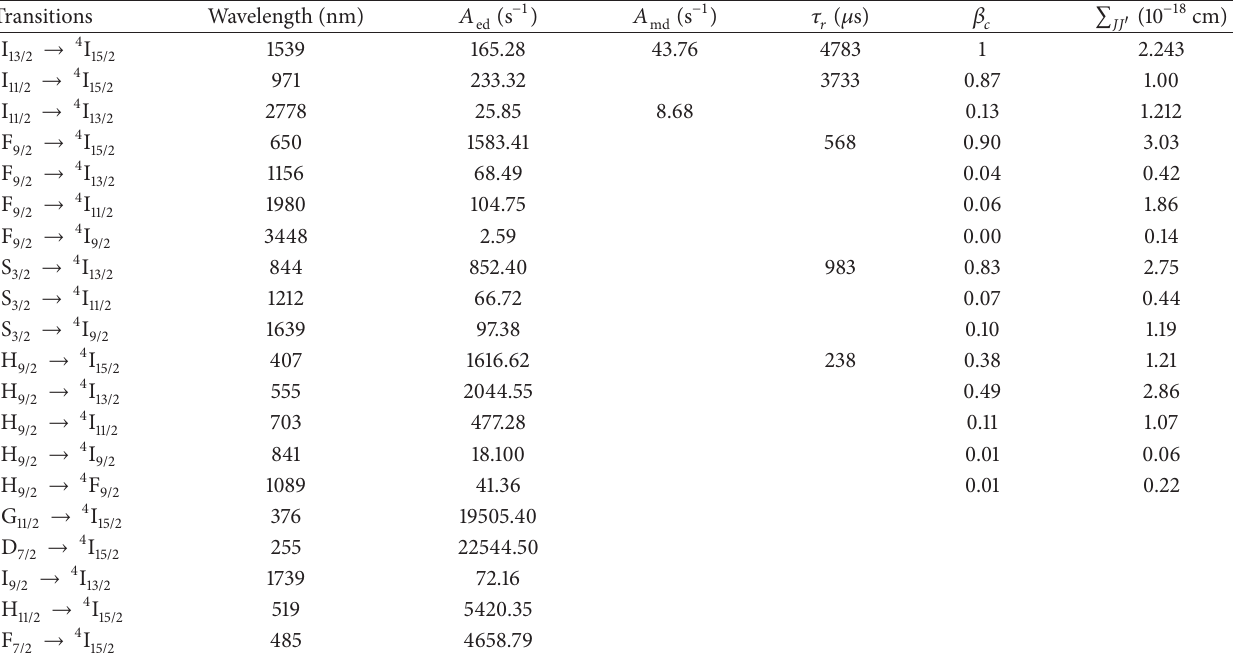
Table 2: The spectral parameters for Er 3+ ions in EBBO